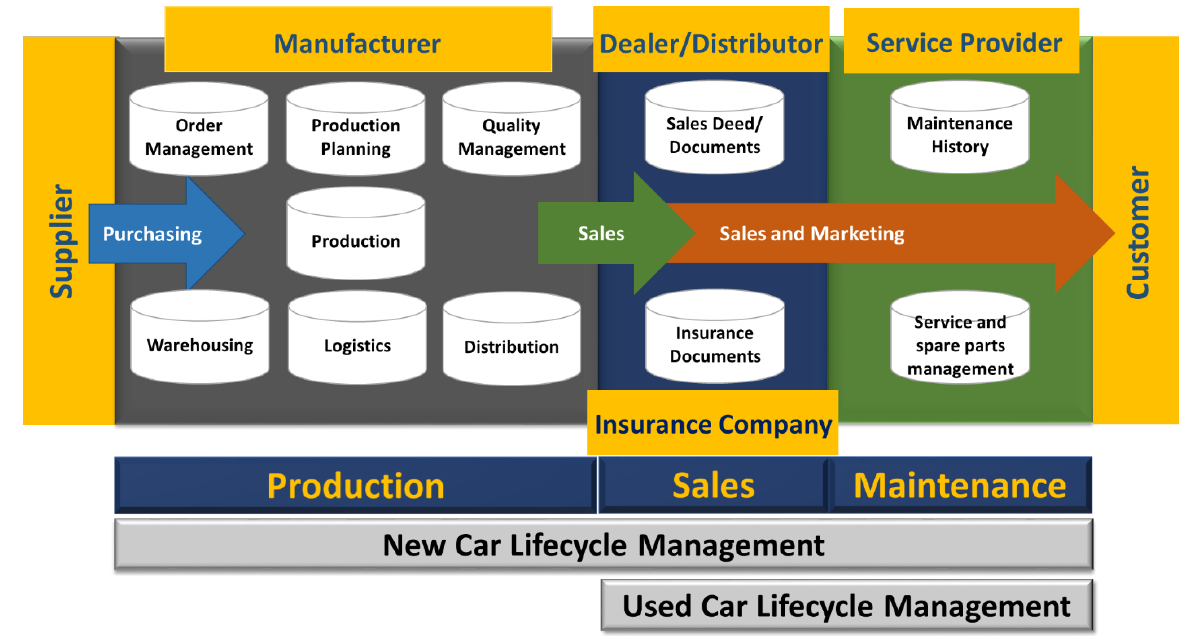
Figure 1. Automotive supply chain processes.